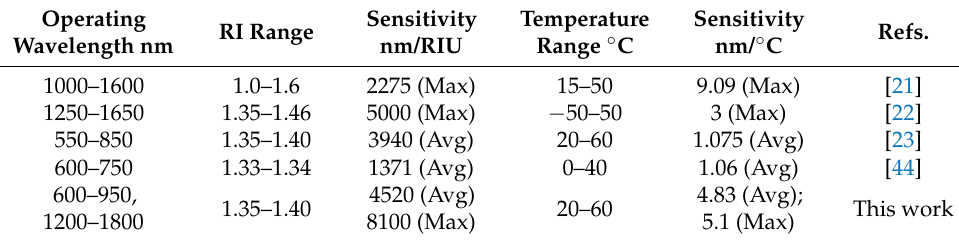
Table 2. Comparison results of the sensitivities of the proposed SPR-based PCF sensor with other works.